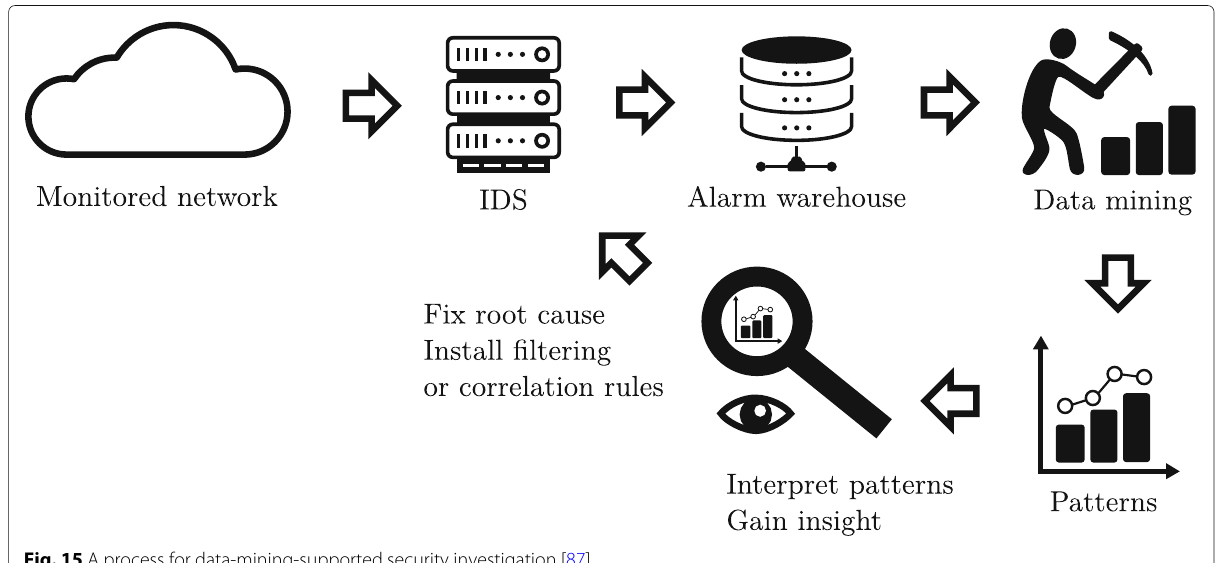
Fig. 15 A process for data-mining-supported security investigation [87]